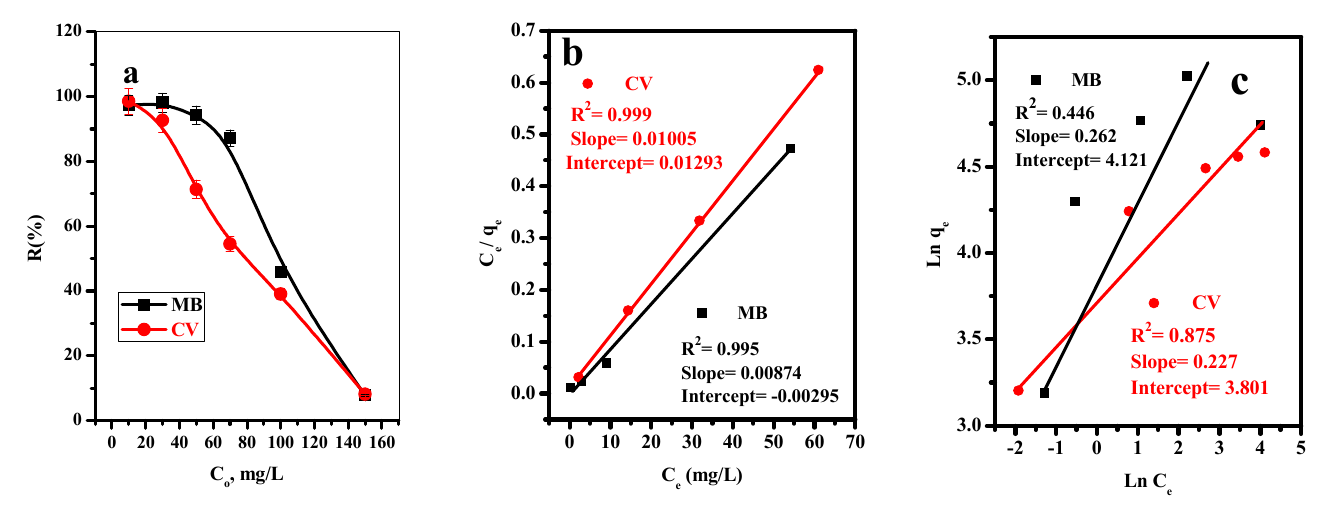
Figure 4. ( a ) Effect of initial dye concentration on adsorption percent of MB and CV, ( b ) Langmuir isotherm model, and ( c ) Freundlich isotherm model (t = 8 min for MB and 10 min for CV, [dye] = 10, 30, 50, 70, 100, 150 mg/L, dose = 20 mg, pH = 7, T = 25 ◦ Table 3. Adsorption isotherms parameters for the sorption of MB and CV-dyes on modified biochar.